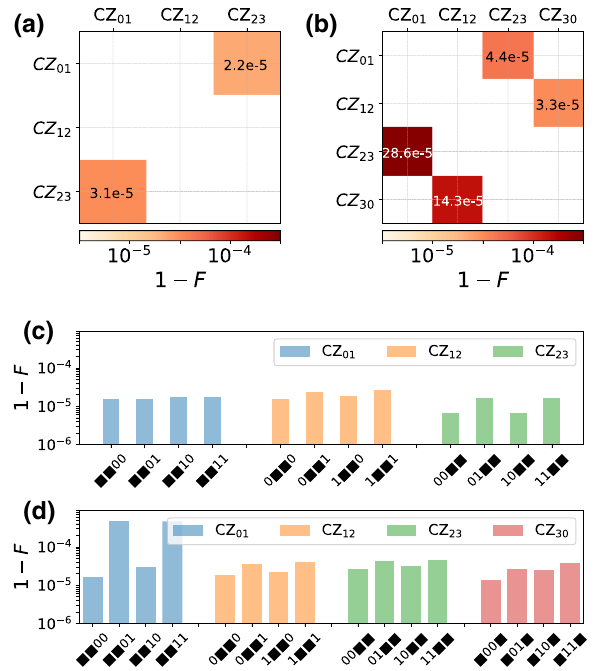
FIG. 8. Error matrix of simultaneous CZ gates in (a) the four- qubit chain system and (b) the four-qubit square system. (c),(d) CZ gate error with the other two nonparticipating qubits in four different state configurations (i.e., 00, 01, 10, 11) for the four-qubit chain system and the four-qubit square